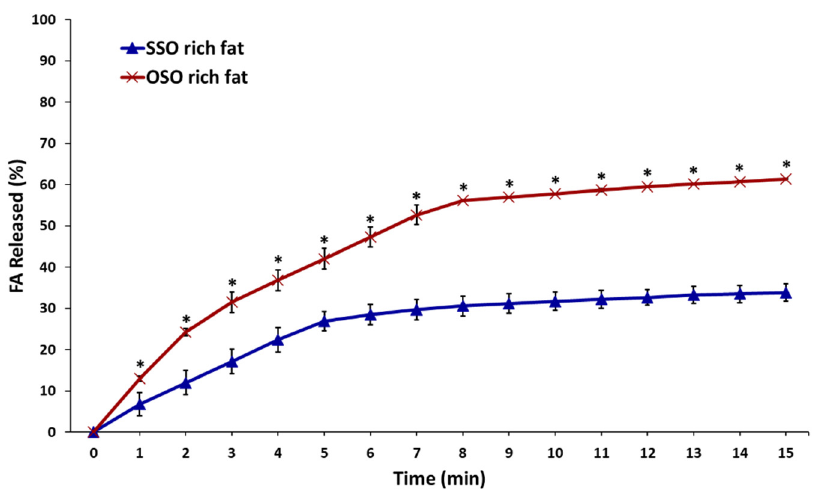
Figure 5. Free fatty acids released (%) of the SSO-rich fat and OSO-rich fat by in vitro pH-stat digestion model. * Mean on the graph are significantly different by Student’s t -test at p < 0.05 .